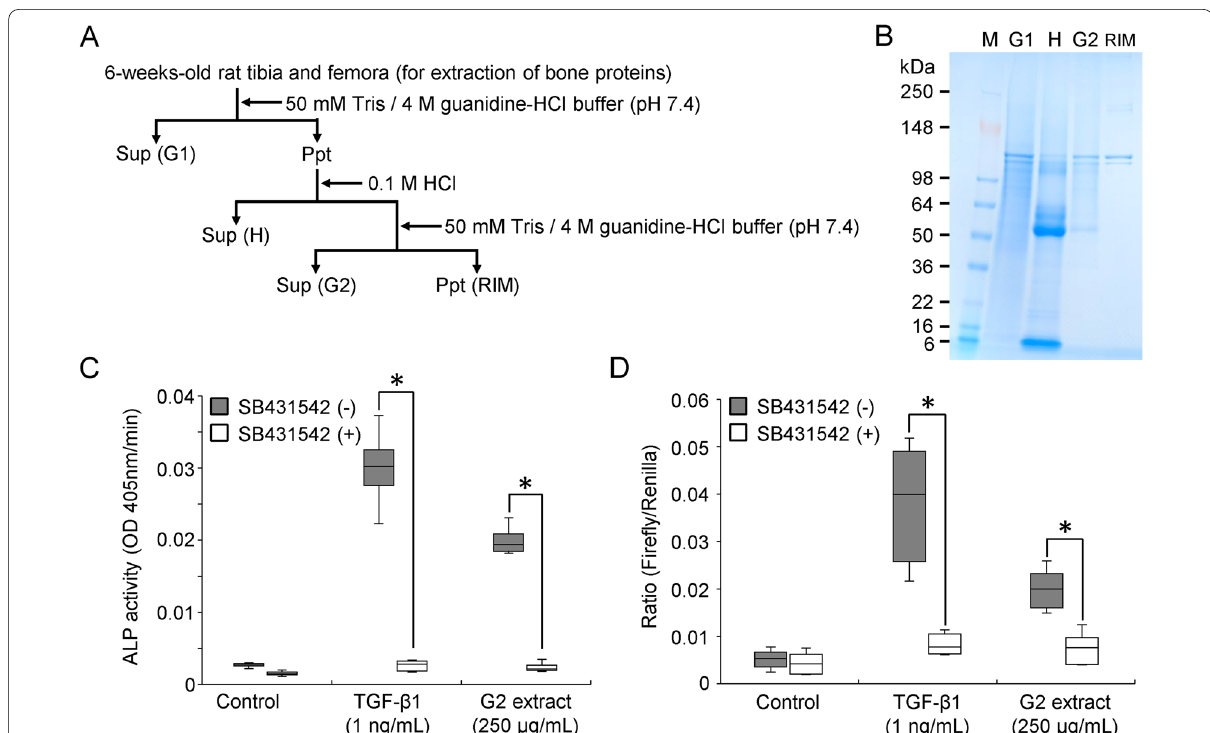
Fig. 3 Detection of TGF‑β activity in the G2 extract. A Flow chart showing the procedures used for the primary extracts of proteins from bone powder. Sup: supernatant, Ppt: precipitate, RIM: residual insoluble materials. B Rat bone powder extracts analysed by SDS–PAGE stained with Bio‑Safe Coomassie Brilliant Blue. M: SeeBlue ® Plus2 Pre‑Stained Standard. C ALP‑inducing activity of HPDL cells exposed to the G2 extract (250 μg/ mL) and CF‑hTGF‑β1 (1 ng/mL) without ( ) or with ( ) SB431542. Data in box indicate the 25–75% tiles of the interquartile range (IQR), and the − + end of whiskers indicates maximum and minimum values, respectively. The median is represented as line located in the middle of box (* p <